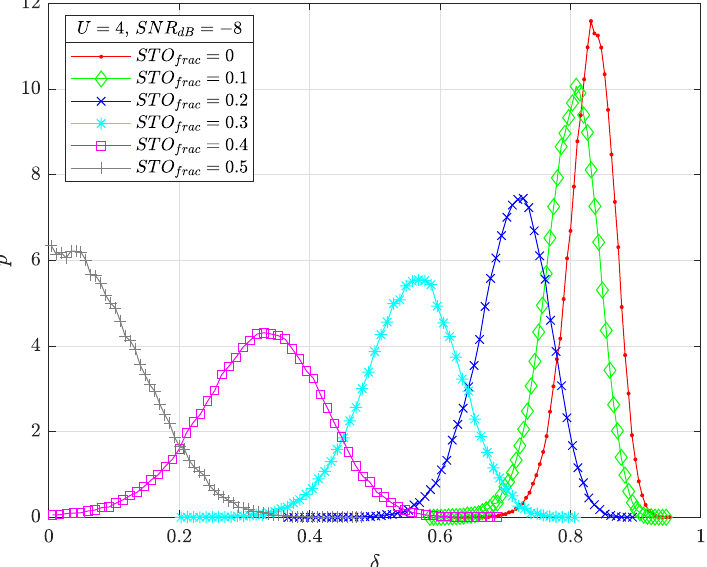
0,0.1, . . . ,0.5 for U = 4, SNR dB = { }